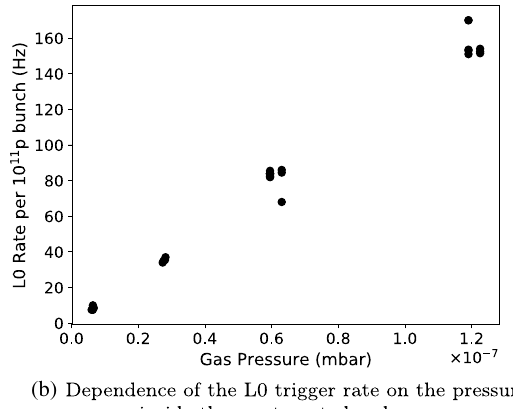
FIG. 3. Trigger system performance.